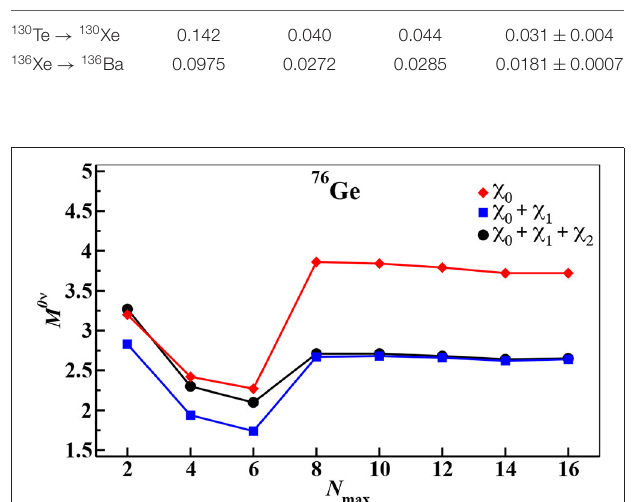
FIGURE 17 | Calculated M 0 ν values for the 76 Ge → 76 Se decay as a function of N max : shown are truncations of the χ n expansion up to χ 0 (red diamonds), up to χ 1 (blue squares), and up to χ 2 (black dots). Reproduced from reference [89].